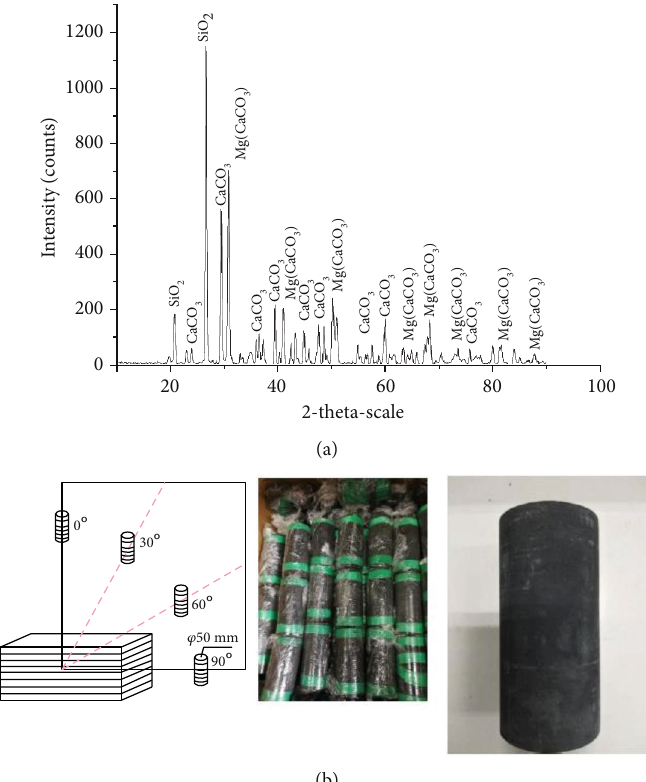
Figure 1: The shale samples and corresponding XRD. The labels are in Figure 1 as follows, Fig.1(a)Di ff raction pattern of the shale based on XRD.Fig.1(b) Arranged shale